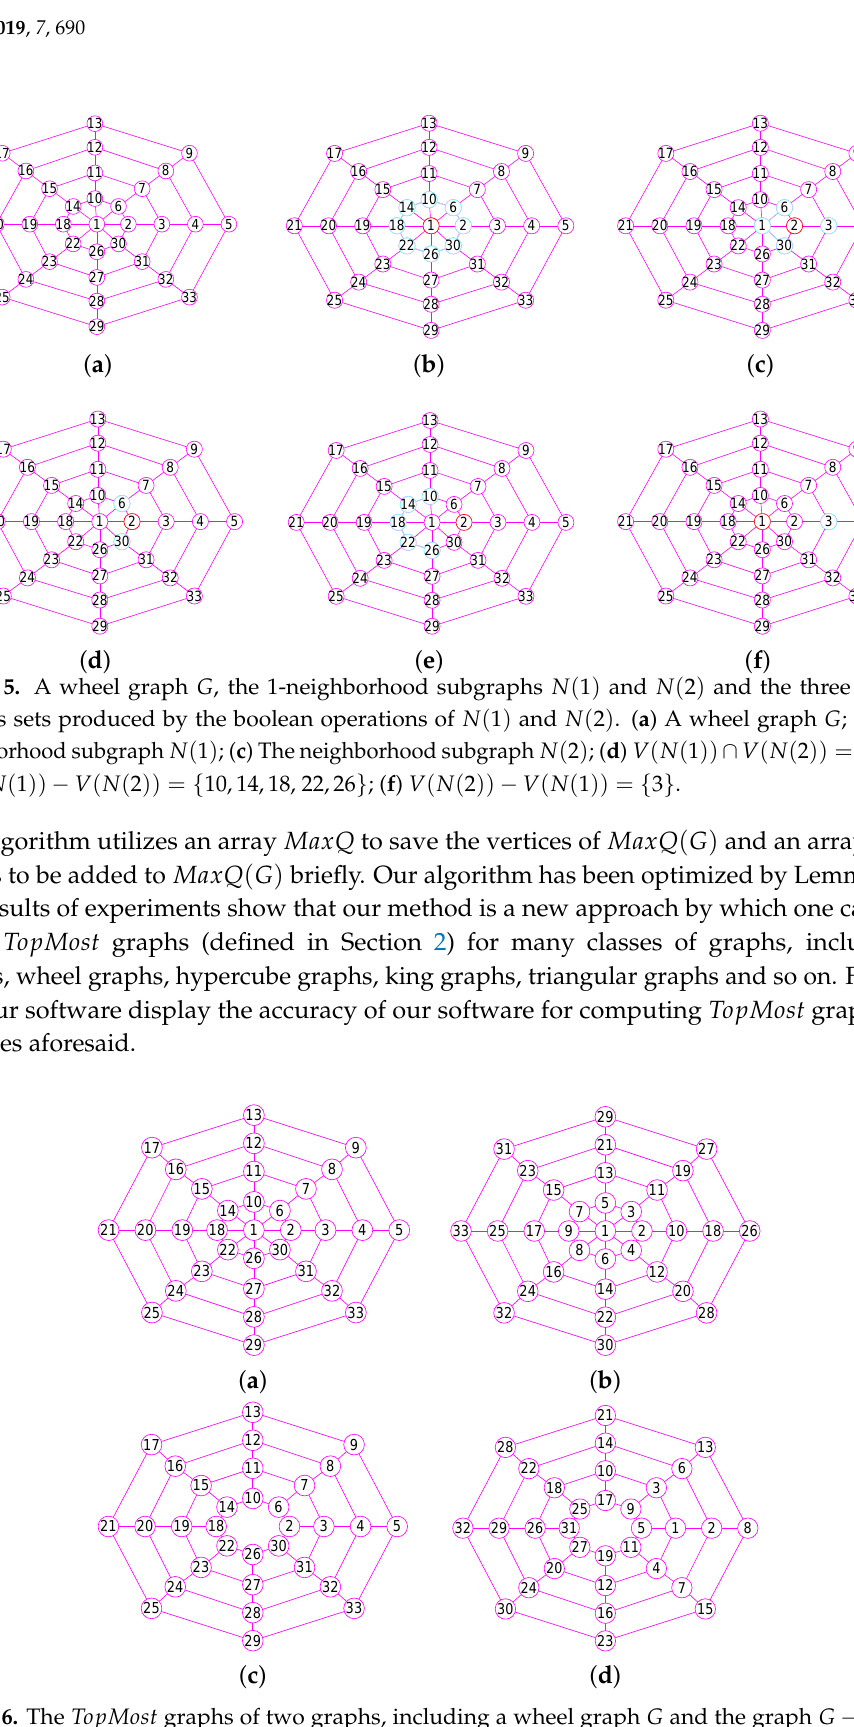
Figure 6. The TopMost graphs of two graphs, including a wheel graph G and the graph G − u with u = 1 ∈ V ( G ) . ( a ) A wheel graph G with 33 nodes and 64 edges; ( b ) The TopMost graph of G ; ( c ) The graph G − u of 32 vertices and 56 edges; ( d ) The TopMost graph of G − u